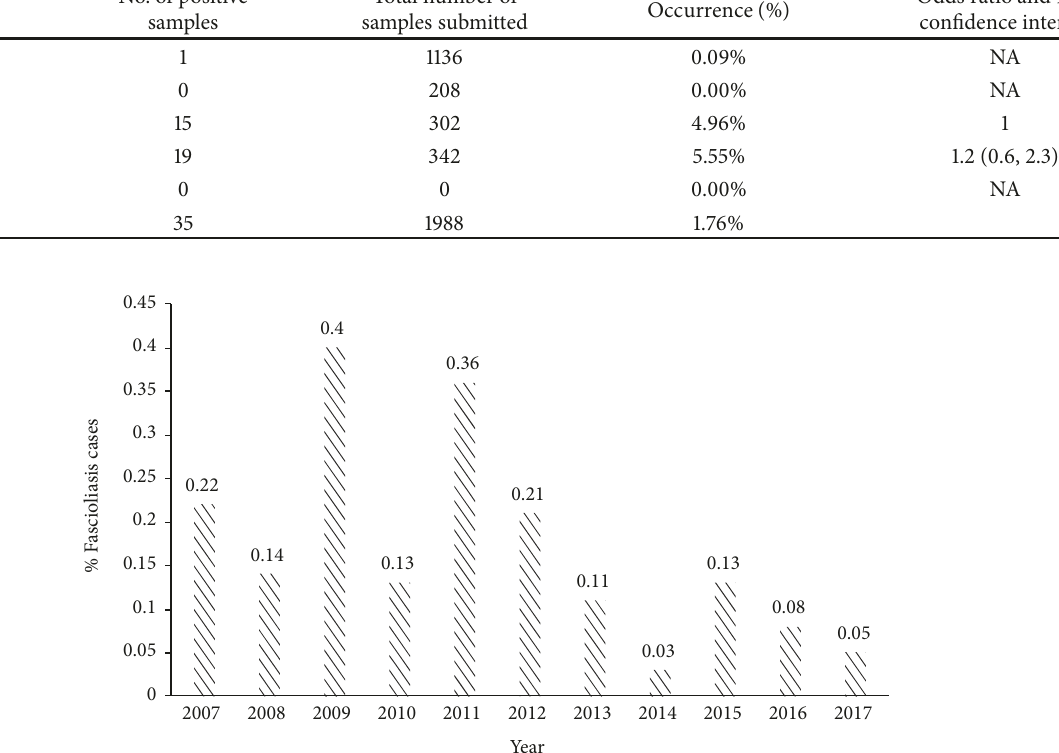
Table 2: Prevalence of bovine fascioliasis cases for eleven-year period from five Regional Veterinary Laboratories in Peninsular Malaysia. RVL